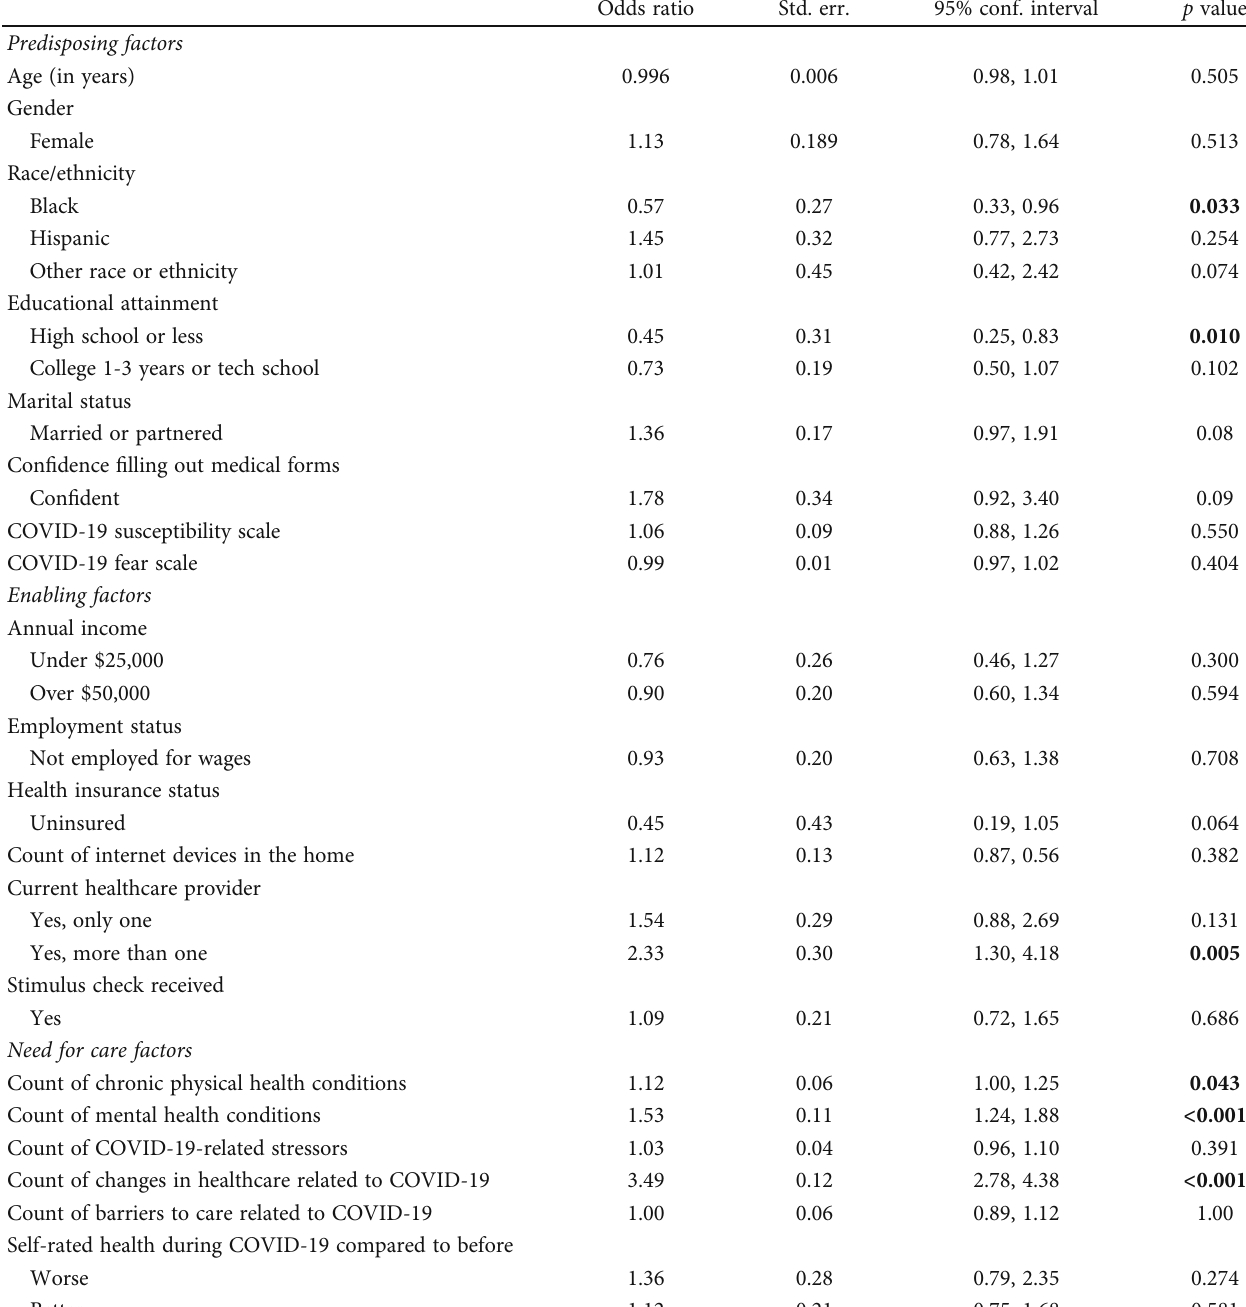
Table 2: Odds of adopting telemedicine during the COVID-19 pandemic ( n = 1,137 ). Odds